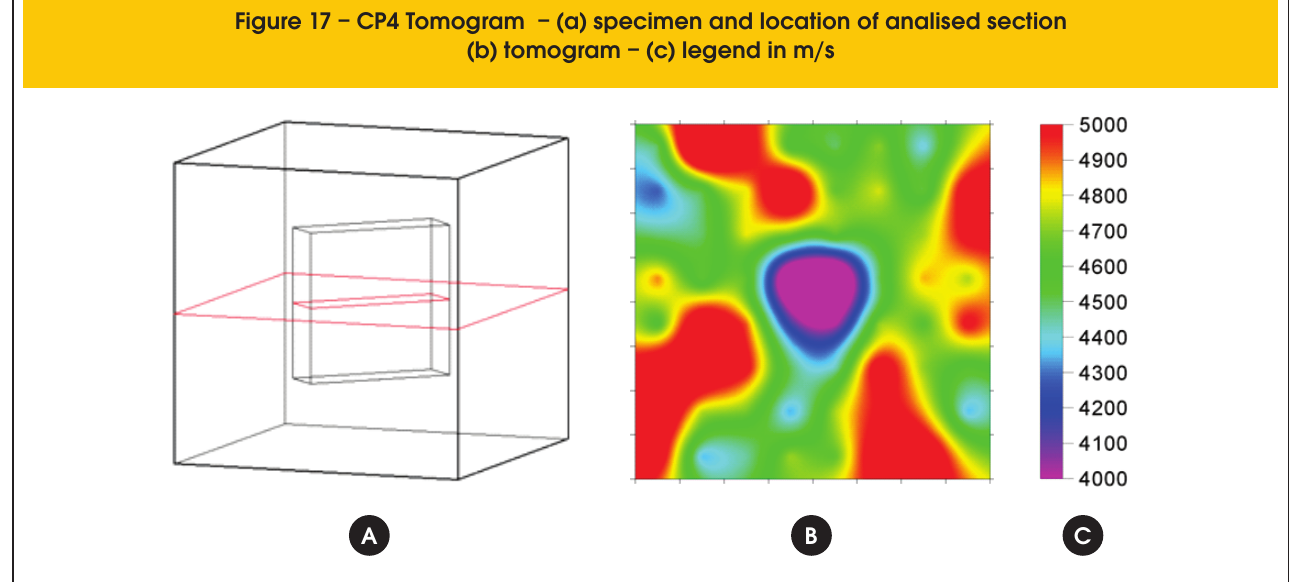
Figure 17 – CP4 Tomogram – (a) specimen and location of analised